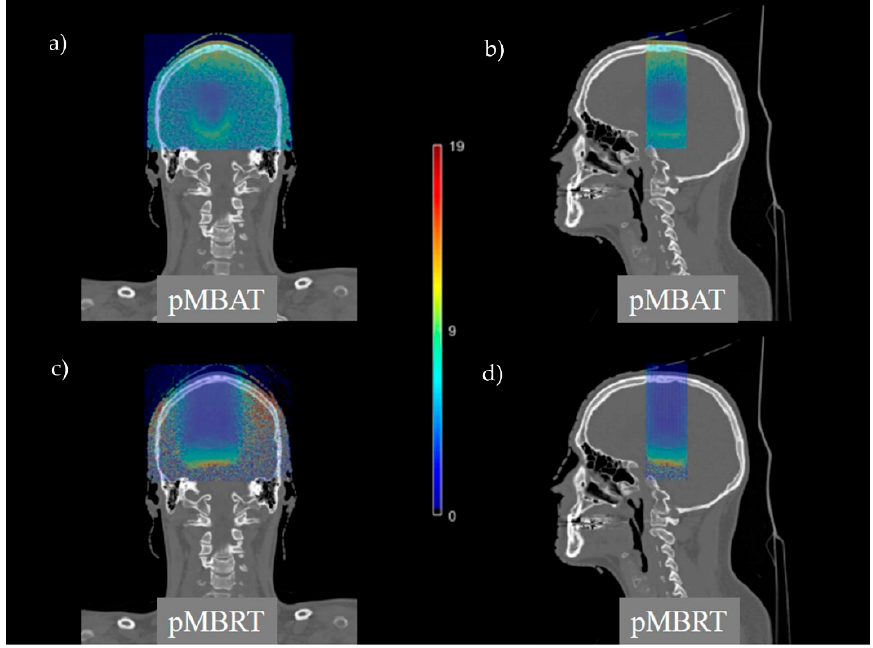
Figure 7. Coronal and sagittal views of LET d distributions in pMBAT ( a , b ) and pMBRT ( c , d ).